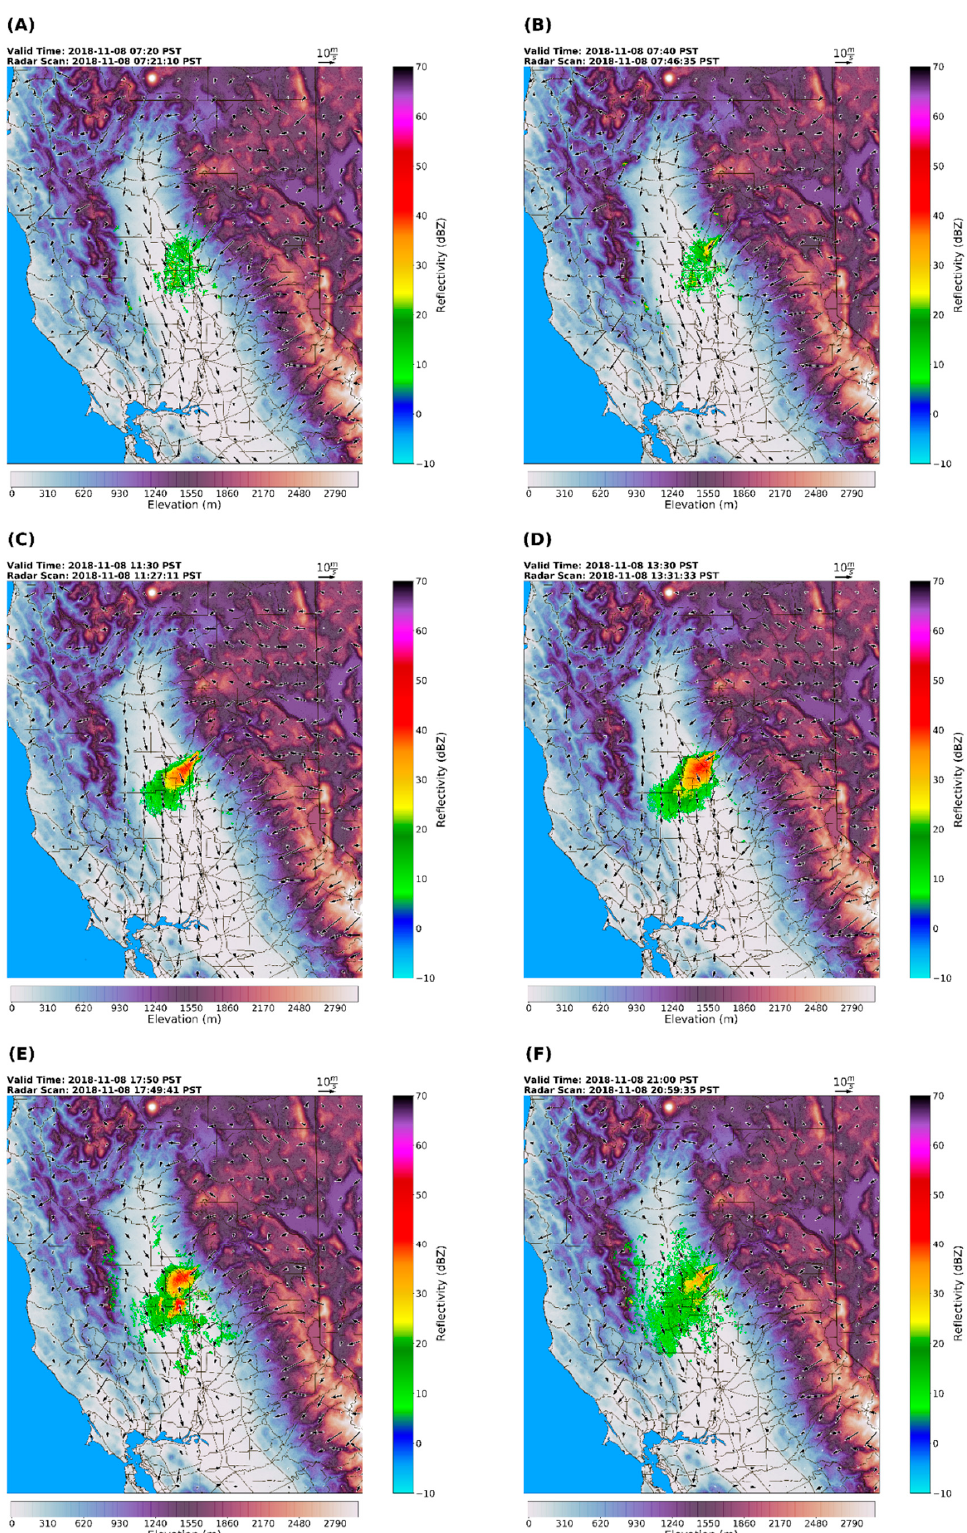
Figure 9. KBBX radar base reflectivity, WRF D2 terrain and 10 m winds (vectors). Radar scan times are plotted with the nearest WRF output times of 07:20, 07:40, 11:30, 13:30, 17:50, and 21:00 PST 8 November for subplot ( A ), ( B ), ( C ), ( D ), ( E ), ( F ) , respectively.